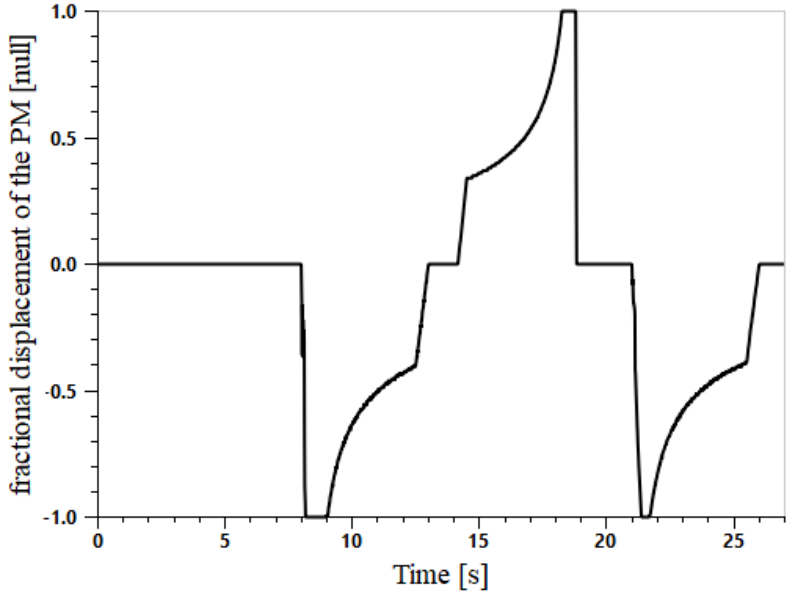
Figure 17. The PM displacement curve of the proposed system when the excavator bucket is